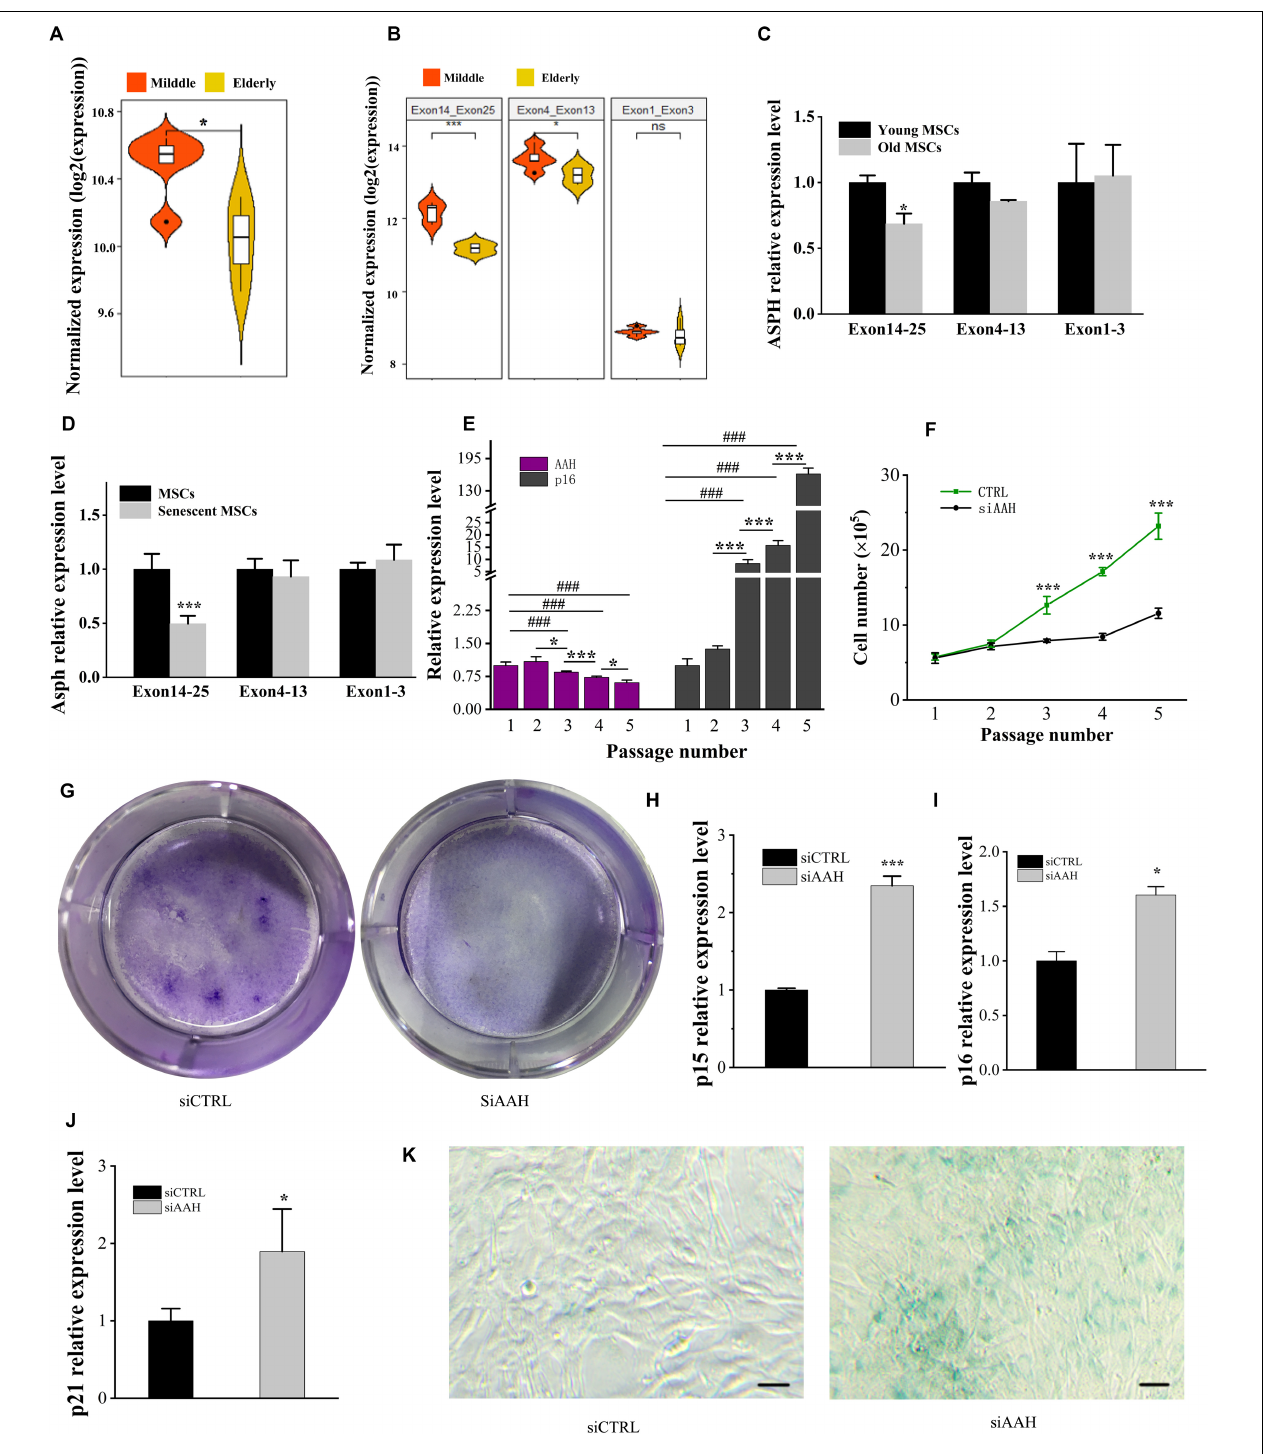
FIGURE 4 | Deficiency of ASPH accelerates cellular senescence in BMSCs. (A) Mean expression of ASPH in the BMSCs from middle-aged individuals and elderly aged individuals (Raw data was obtained from GSE35955). (B) Mean expression of different ASPH regions in the BMSCs from middle-aged individuals and elderly aged individuals (Raw data was obtained from GSE35955). (C) The expression of ASPH isoforms in the BMSCs from young and old individuals. (D) The expression of Asph isoforms in the young or senescent BMSCs. (E) The negative correlation of AAH and p16 expression during passaging (P1–P5) of BMSCs. (F) Doublings of BMSCs interfered with AAH siRNA in vitro . (G) Giemsa staining for the CFU-F colonies of BMSCs from BMSCs interfered with AAH siRNA in vitro . (H–J) Expression of p15 (H) , p16 (I) , and p21 (J) in BMSCs with depletion of AAH. (K) Representative images of SA- β -Gal staining of BMSCs in Asph siRNA transfected and control group. Scale Bar = 100 µ m. These experiments were replicated three times. Error bars show standard deviation. * P < 0.05, *** P < 0.001, ### P < 0.001.